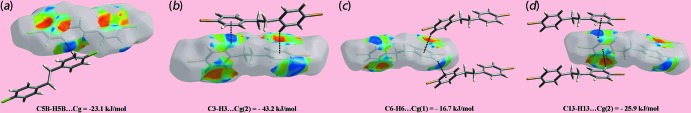
Views of the Hirshfeld surfaces mapped with the shape index property for (a) (I), mol­ecule B, (b)–(d) (II), highlighting inter­molecular C—H⋯π inter­actions through black dotted lines.